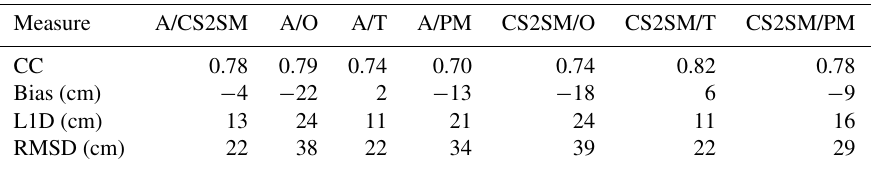
Table 5. Average difference measures between the AARI ice chart SIT (A), CS2SMOS SIT (CS2SM) and SIT of the three ice models. O refers to ORAS5, T refers to TOPAZ4 and PM refers to PIOMAS.